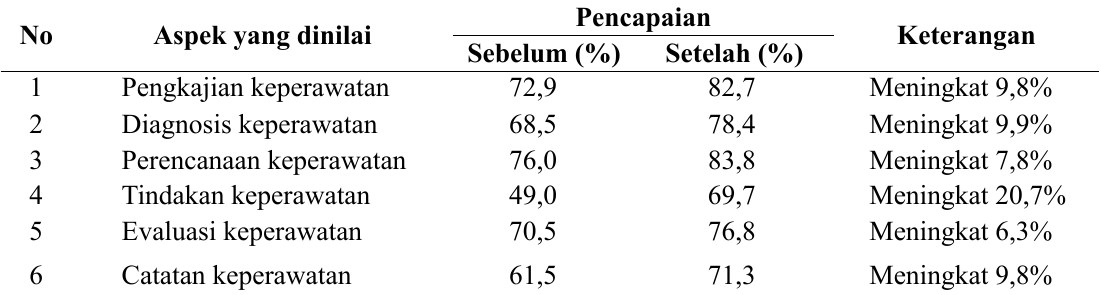
Tabel 8. Perbandingan kinerja komunikasi efektif SBAR sebelum dan setelah pelaksanaan